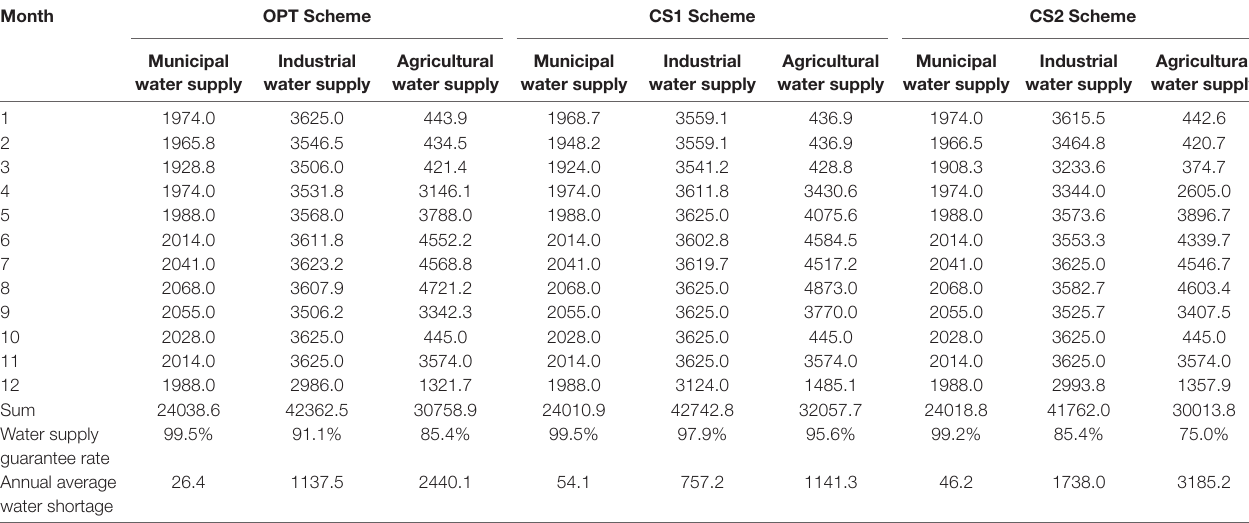
TABLE 4 | The process of water supply for different schemes units: 10 4 m 3